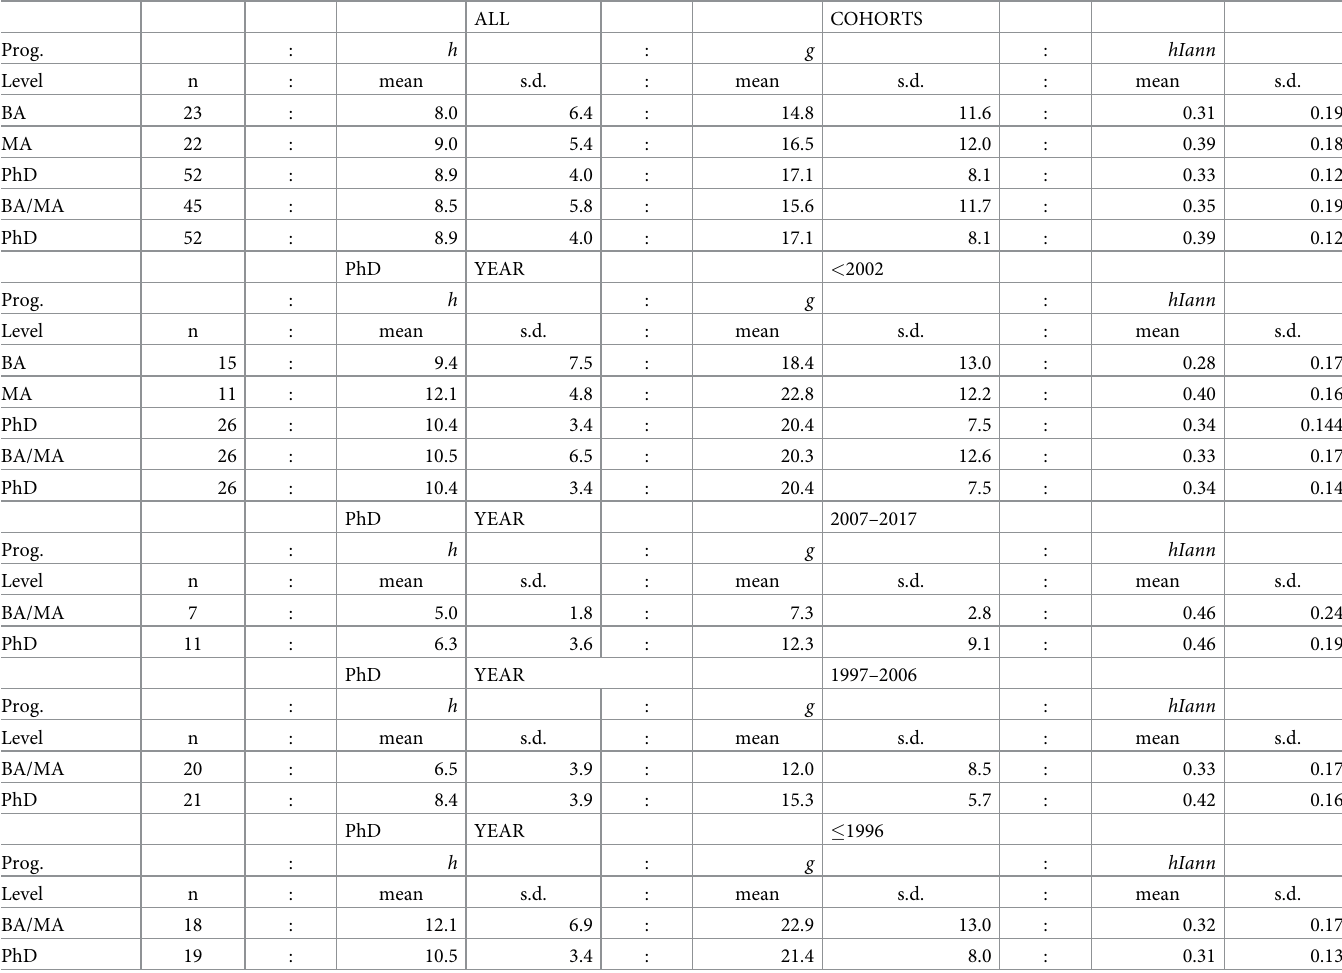
Table 2. Trimmed-sample productivity means, overall and by specified cohorts of professional age (years since